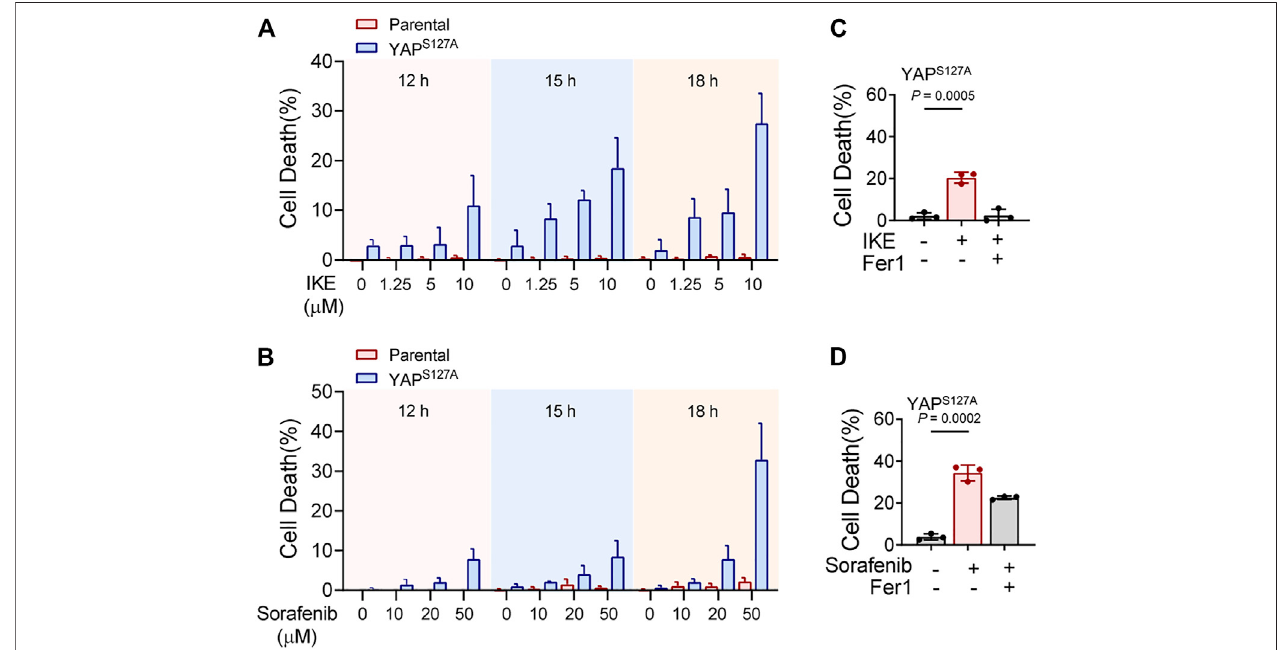
FIGURE 4 | YAP activation sensitizes ferroptosis triggered by pharmacological inhibition of system xc-cystine/glutamate antiporter in HCC cells. (A) Parental LM3 cells and YAP S127A -overexpressing cells were treated with IKE with indicated concentrations. At different time points after IKE treatment, cell death was measured. (B) Cell death of parental LM3 cells and YAP S127A -overexpressing cells treated with sorafenib for indicated time. (C) Inhibition of 10 μ M IKE-induced cell death by Fer-1 in YAP S127A -overexpressing LM3 cells. (D) Inhibition of 50 μ M sorafenib-induced cell death by Fer-1 in YAP S127A -overexpressing LM3 cells. n (cid:2) 3 biologically independent samples per